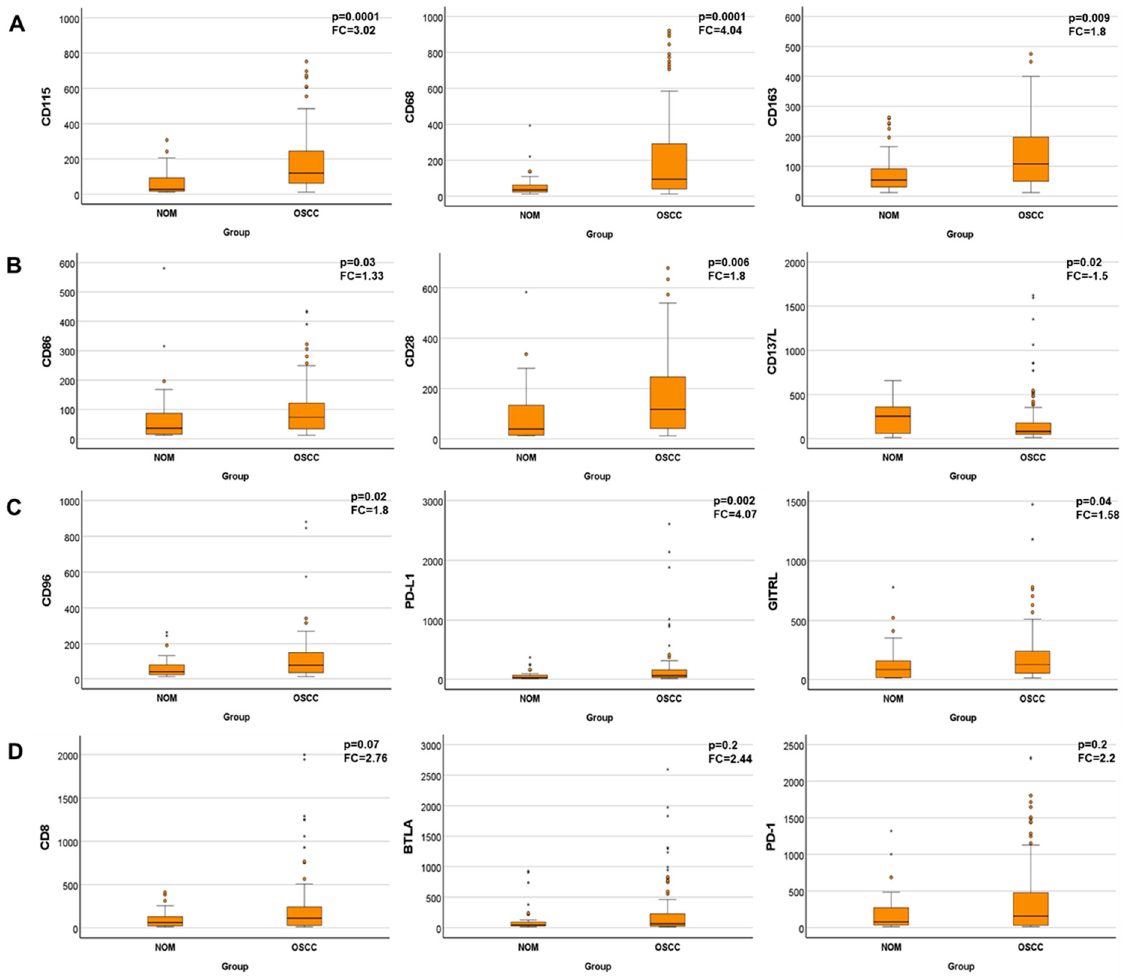
Figure 2. Boxplots of the comparison of expression rates of immune modulators between OSCC and NOM groups. Only results for genes that are significantly deregulated are shown. Analysis of ( A ) specific cell markers for MDSCs (CD115) and macrophages (CD68, CD163), ( B ) activating ligands (CD86, CD28, CD137L), ( C ) inhibitory receptors and ligands (CD96, PD-L1, GIRTL), ( D ) not significantly but highly dysregulated modulators (CD8, BTLA, PD-1). Number of cases of OSCC n = 98 and NOM cases n = 41. * = extrem